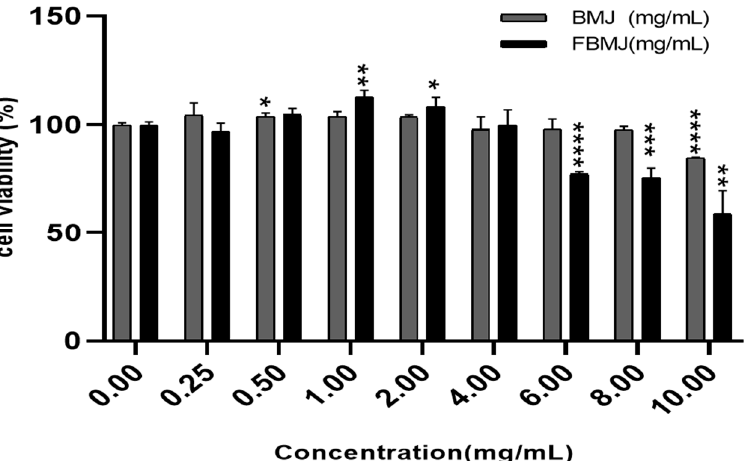
Figure 4. Effects of different concentrations of BMJ and FBMJ on cell survival rate compared with the control group (* p < 0.05, ** p < 0.01, *** p < 0.001, **** p <0.0001). Treatment of the model group with only 500 µ mol/L H 2 O 2 for 24 h resulted in a 24.85% decrease in cell viability ( p < 0.001). In the drug group, the cells were exposed to different concentrations (0.5, 1, and 2 mg/mL) of either BMJ or FBMJ for 24 h and then treated with 500 µ mol/L H 2 O 2 for 24 h, whereby cell viability increased in a dose-dependent manner (Figure 5). Compared to the model group, the drug groups administered concentrations of 0.5 mg/mL BMJ and 1 mg/mL FBMJ exhibited the most significant protective effects against oxidative stress, whereby the cell viability of the two groups increased by 25.8% and 30.22%, respectively. ( p < 0.001). These results suggested that both BMJ and FBMJ can protect C2C12 cells from oxidative